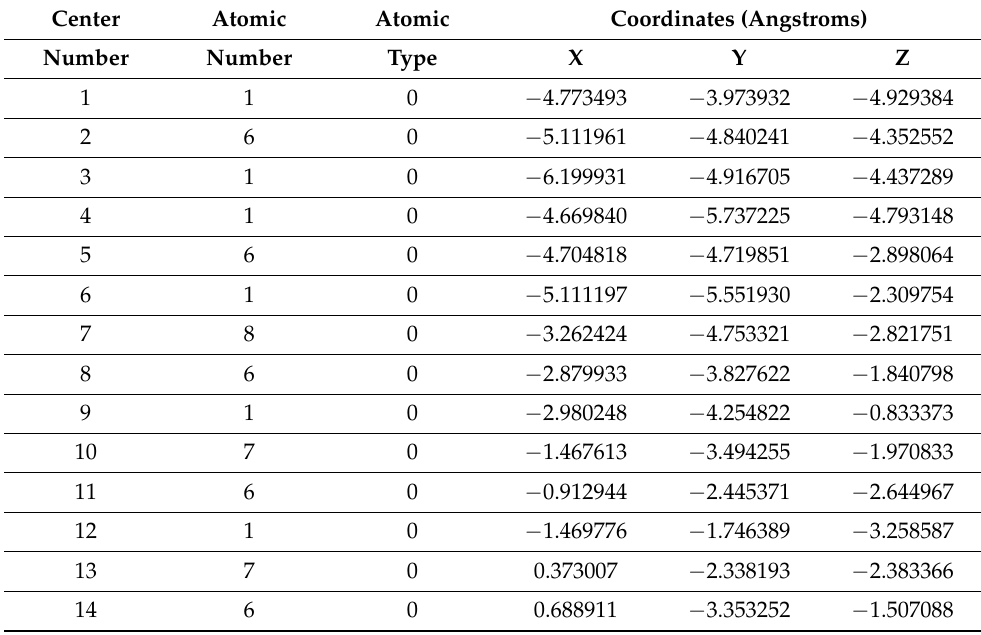
Table A5. Complex MgI 3 LiII 2 with nucleotide triplet